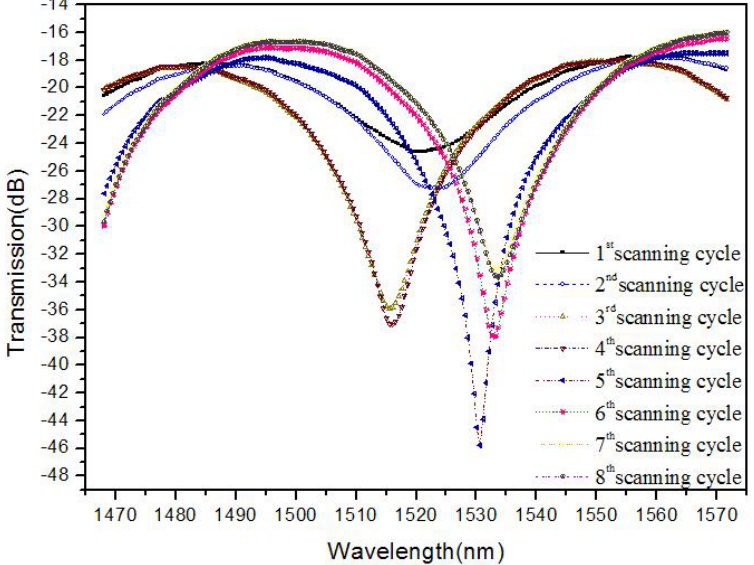
Figure 3. Transmission spectra evolution of the sensor structure during the 1 st –8 th scanning cycle.